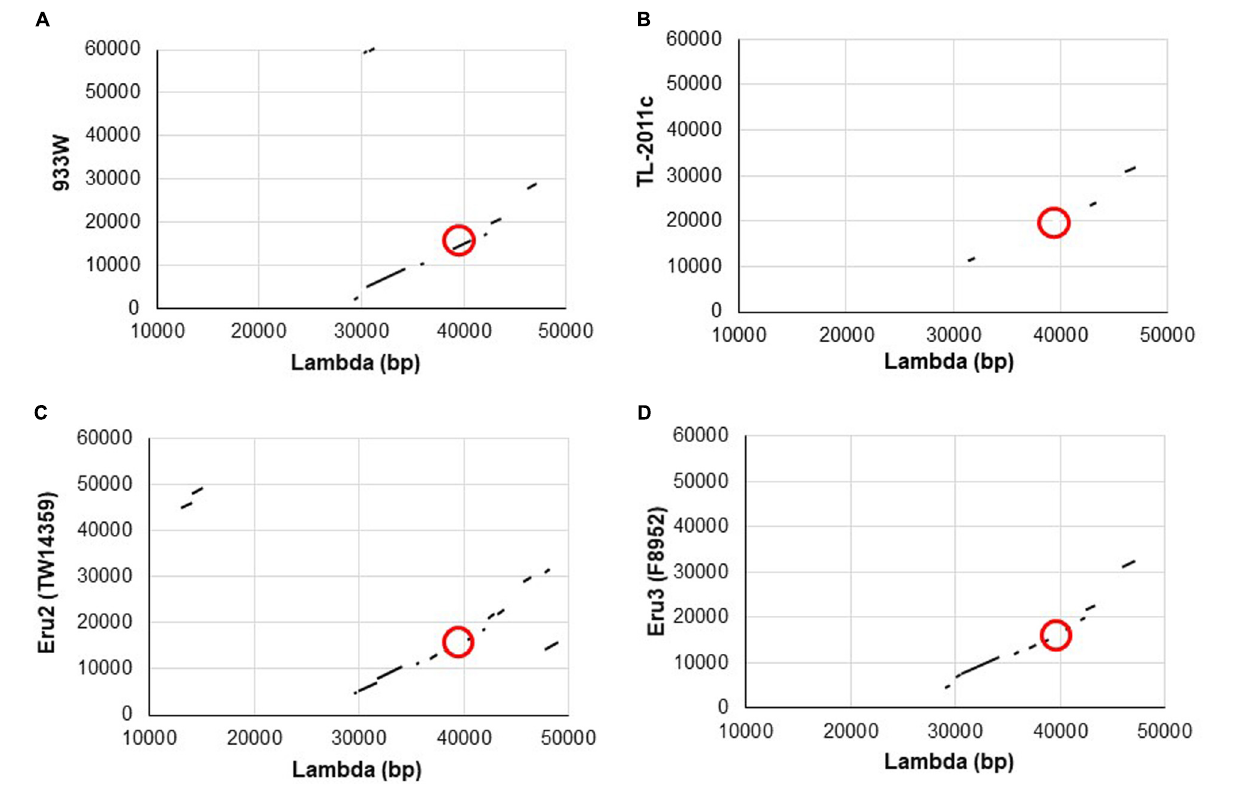
FIGURE 1 | Schematic illustrations of dot matrix views showing nucleotide sequence homology between the genomes of phage lambda and 933W (A) , lambda and TL-2011c (B) , phage lambda and the Eru2-phage of E. coli O157:H7 TW14359 (C) , and lambda and the Eru3-phage of E. coli O157:H7 F8952 (D) . The alignments are based upon BLASTn algorithm and are shown in the plot as line. The query sequence is represented on the X -axis, while the subject is represented on the Y -axis. The numbers on the X- and Y -axis represent the bases of the query and subject sequence, respectively. Plus-strand matches are slanted from the bottom left to the upper right corner. The position of the replication regions is marked with red